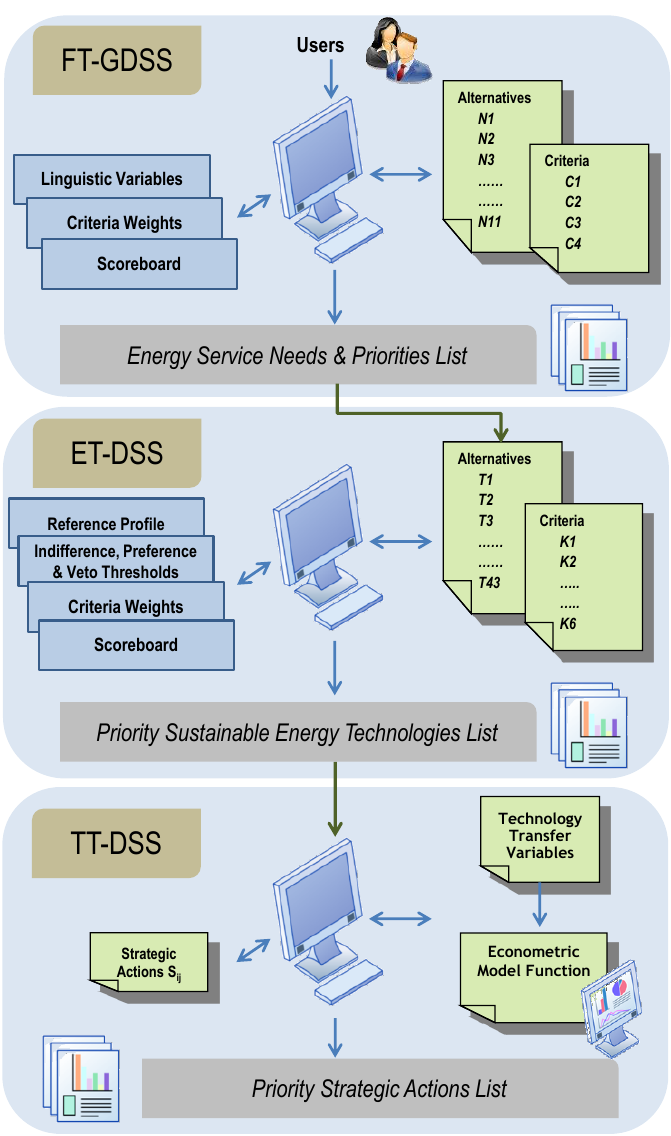
Figure 6. Information decision support system for effective technology transfer (DSS-ΕTT) architecture.